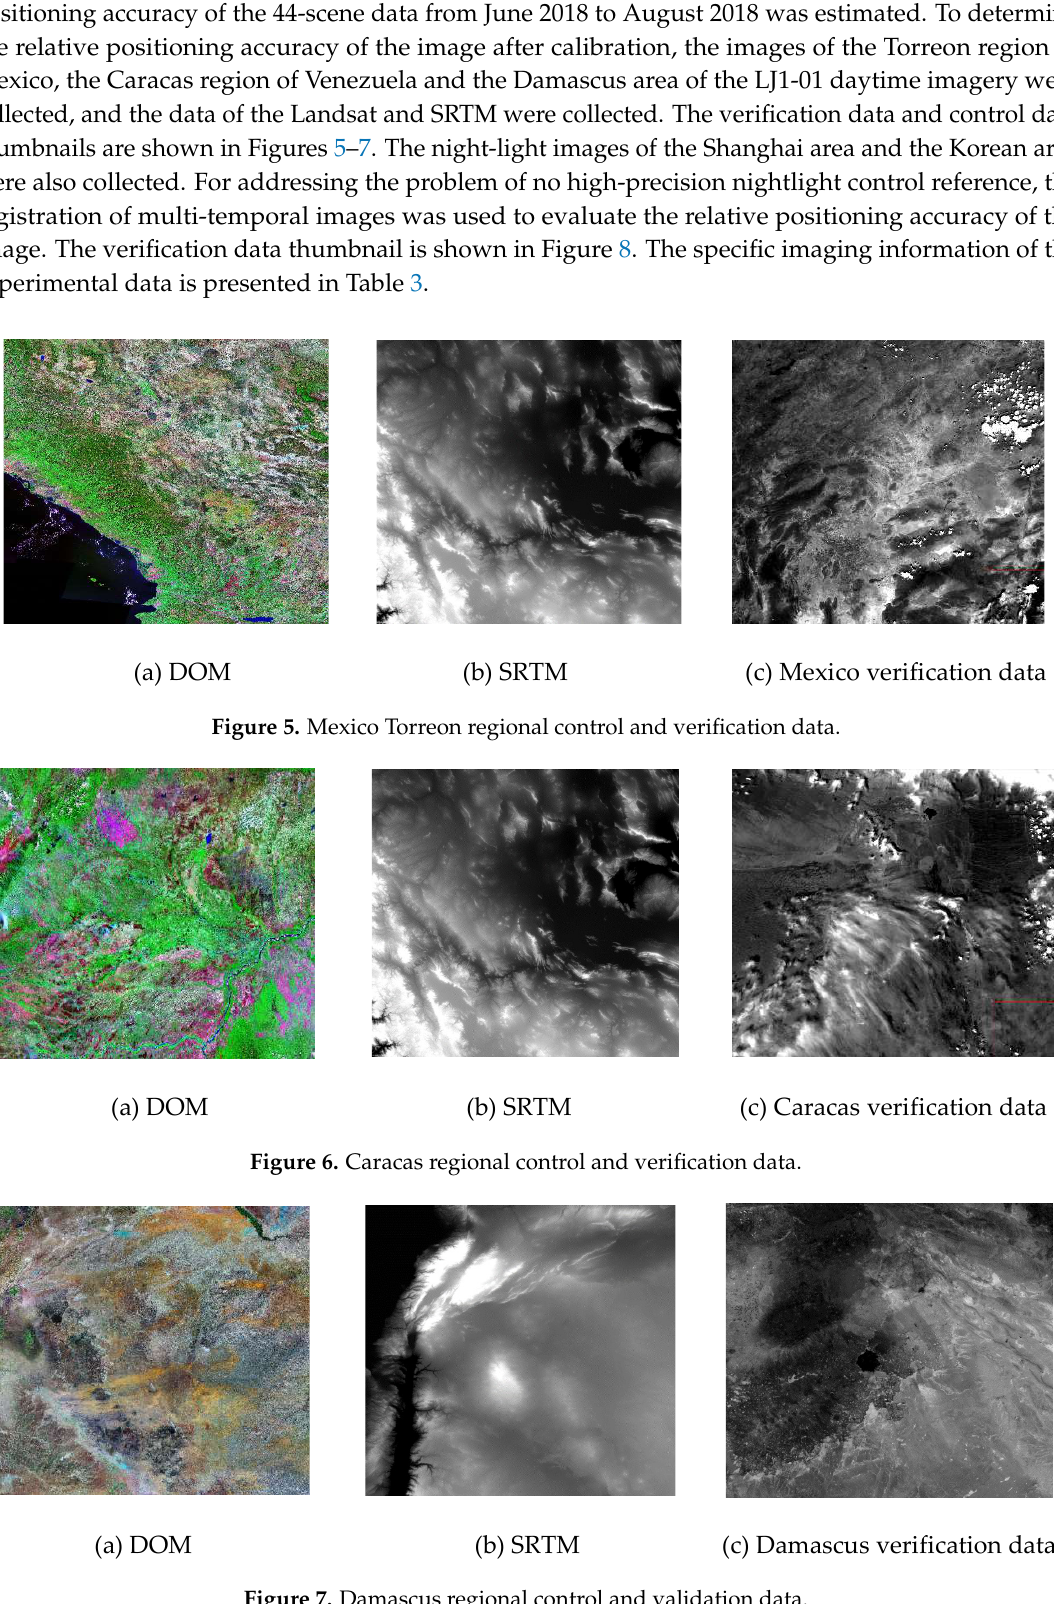
Figure 4. England regional control and calibration data.